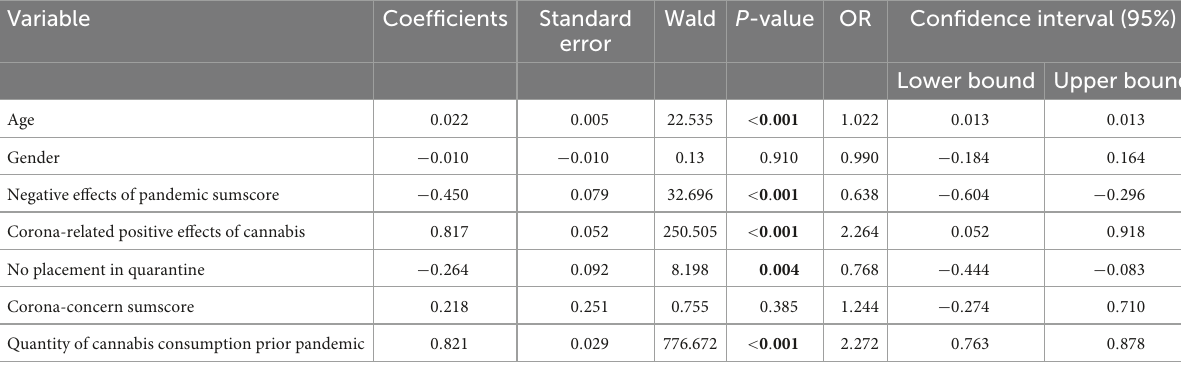
TABLE 3 Predictors of the consumption quantity of cannabis during 1 month of the